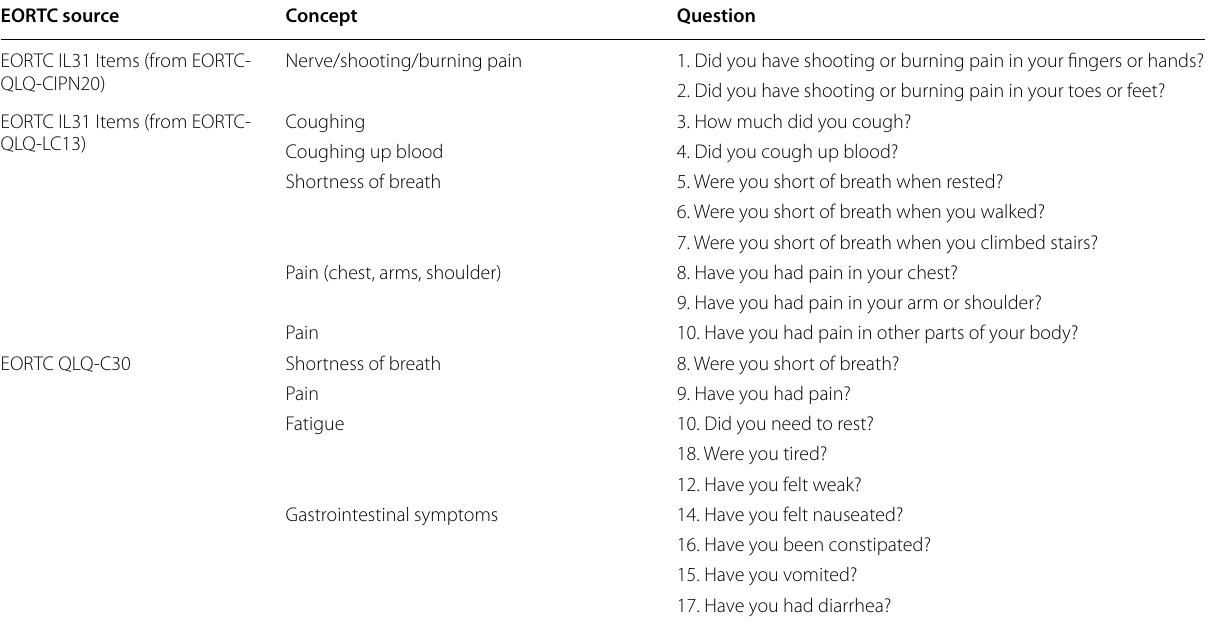
Table 1 Symptom items used in the interviews